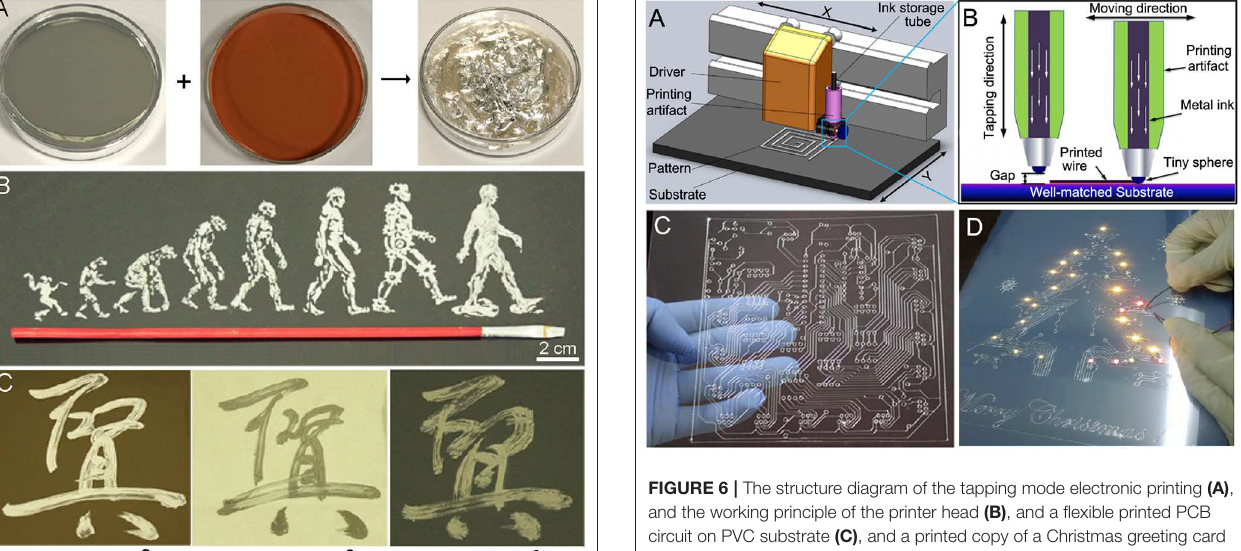
= 0.1) ink on plastic, glass and silicone substrates, respectively.